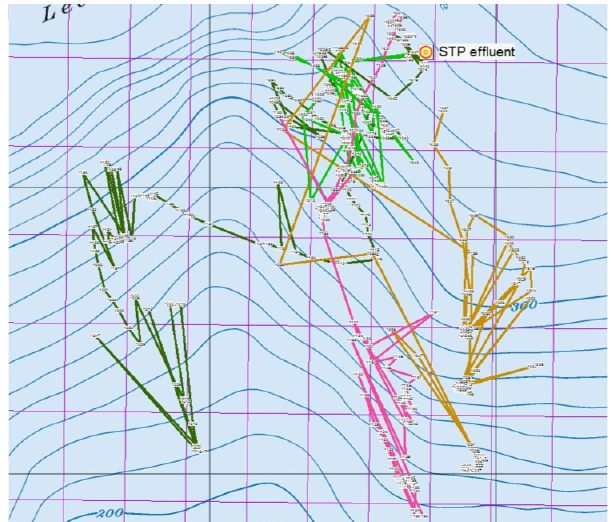
Figure 3: Underwater trajectories of the MIR submersibles in the Bay of Vidy obtained from the raw position data recorded by the surface navigation system (Courtesy of J.-L. Loizeau).